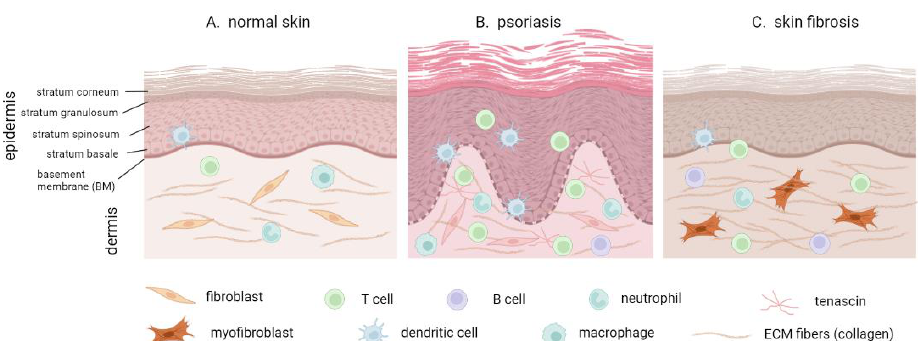
Figure 1. A scheme of the epidermis and dermis in normal skin ( A ), psoriasis ( B ) and fibrosis ( C ). Morphologically, psoriatic inflammation is characterized by epidermal hyperproliferation and thickening (acanthosis), an increased infiltration of immune cells into the dermis and epidermis, alterations in the composition of the dermal ECM, and damage to the BM. Fibrotic skin is characterized by excessive ECM deposition by the dermal myofibroblasts and an increased presence of immune cells in the dermis. Figure created in Biorender.com 14.06.2022.